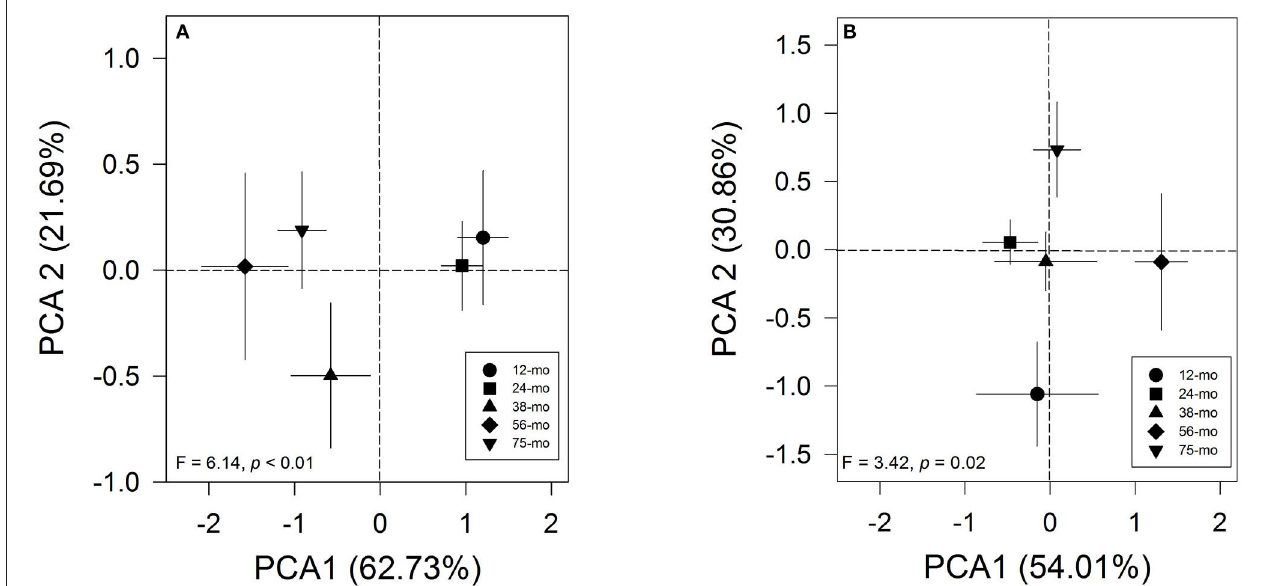
FIGURE 1 | Principal component analysis graph of (A) short-term memory and (B) long-term memory processes across age groups. Each symbol represents the age of animals (circle: 12-months-old ( n = 6 per group); square: 24-months-old ( n = 13 per group); triangle: 38-months-old ( n = 6 per group); diamond: 56-months-old ( n = 5 per group); inverted triangle: 75-months-old ( n = 9 per group). For short-term memory analysis, we used Recognition Index information (RI) from the Social Interaction test and the Novel Local Recognition/Novel Object Recognition test. For long-term memory analysis, the principal component analysis (PCA) included information of latency to the first visit of the escape hole and the reference and working memory errors to find the escape hole during the trials of the Barnes maze test. The F and p values of the one-way PERMANOVA test are plotted.